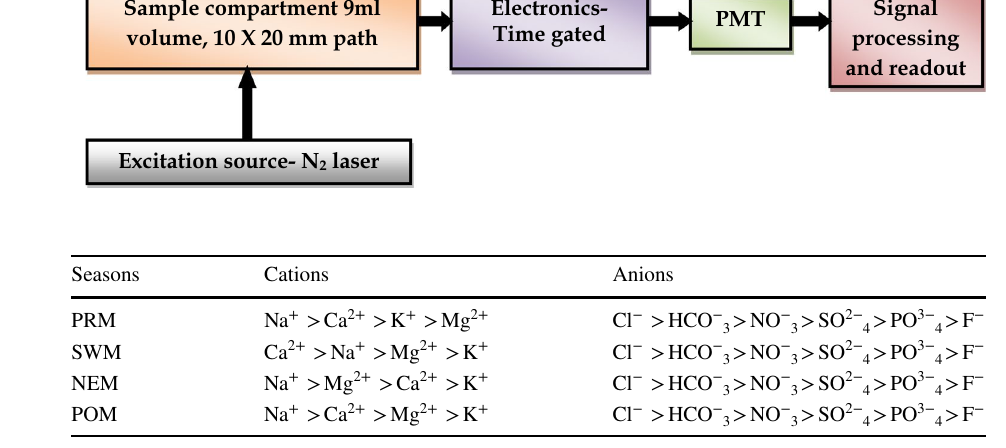
Fig. 2 Block diagram of laser Uranium analyzer